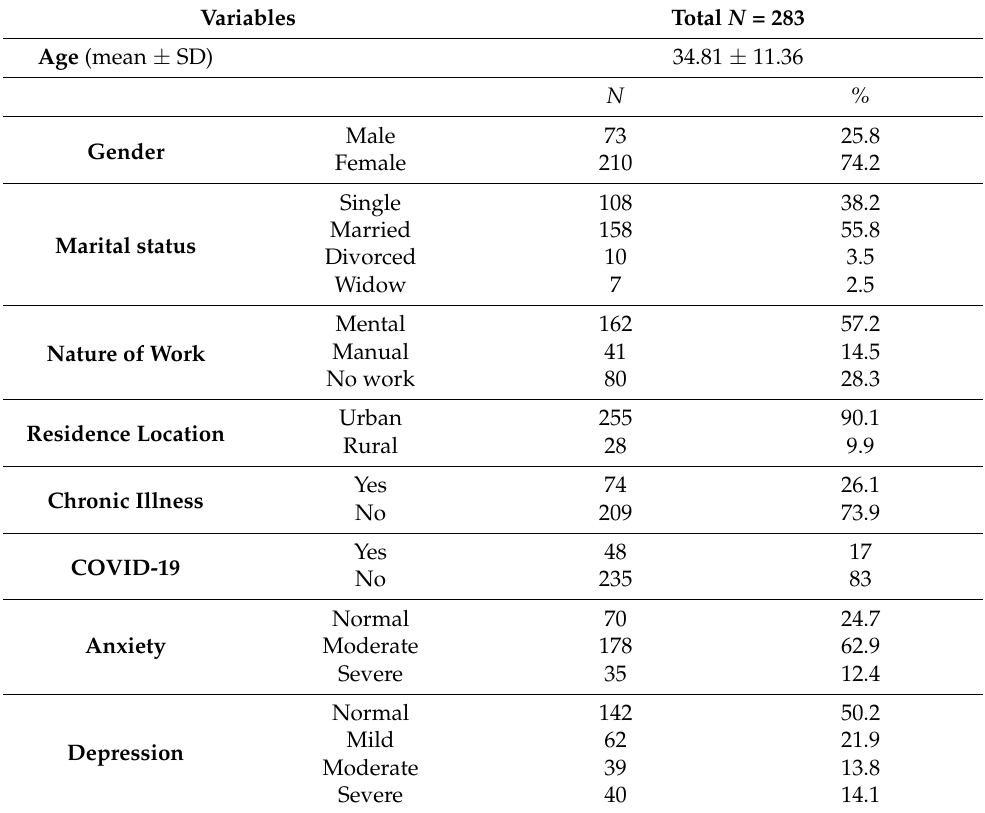
Table 1. Demographic and clinical data of the study population. Responses to the questionnaire, which included sociodemographic and clinical questions (section I), anxiety and depression assess- ment questions (sections III and IV, respectively), were recorded. Data are expressed as numbers ( N ) and percentages (%) or mean ± standard deviation